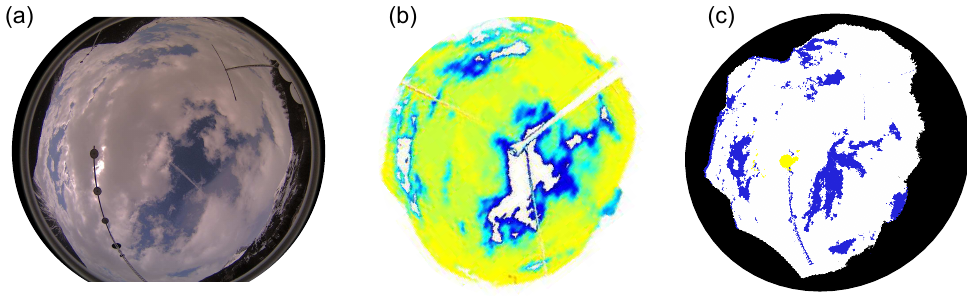
Figure 7. The cloud situation on 4 April 2016 10:00UTC (a) on an image from Mobotix and the cloud fraction determined from (b) IRCCAM (temperature range from 244K (blue) to 274K (yellow)) and (c) Mobotix (white: clouds, blue: cloud-free, yellow: area around sun).